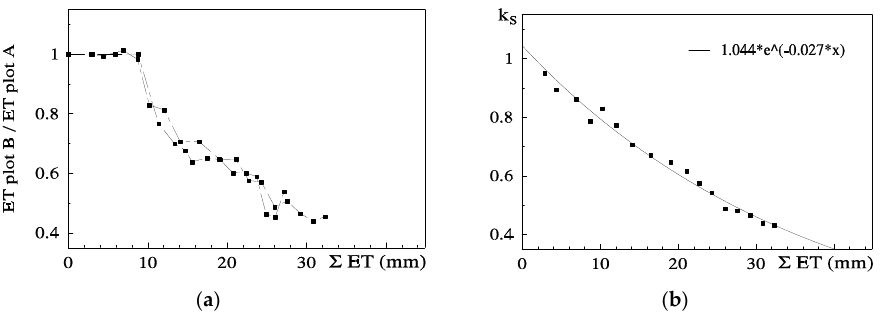
Figure 6. Relationship between ( a ) relative ET (RET) on the stressed Plot B (ET Plot B/ET Plot A, where A is the well irrigated reference) and correspondent cumulated ET since the day after irrigation and ( b ) Ks (ET stressed plot/ETc) and cumulated measured ET, with the regression line, on a peach orchard (June 1994, Sado Valley, Portugal). From